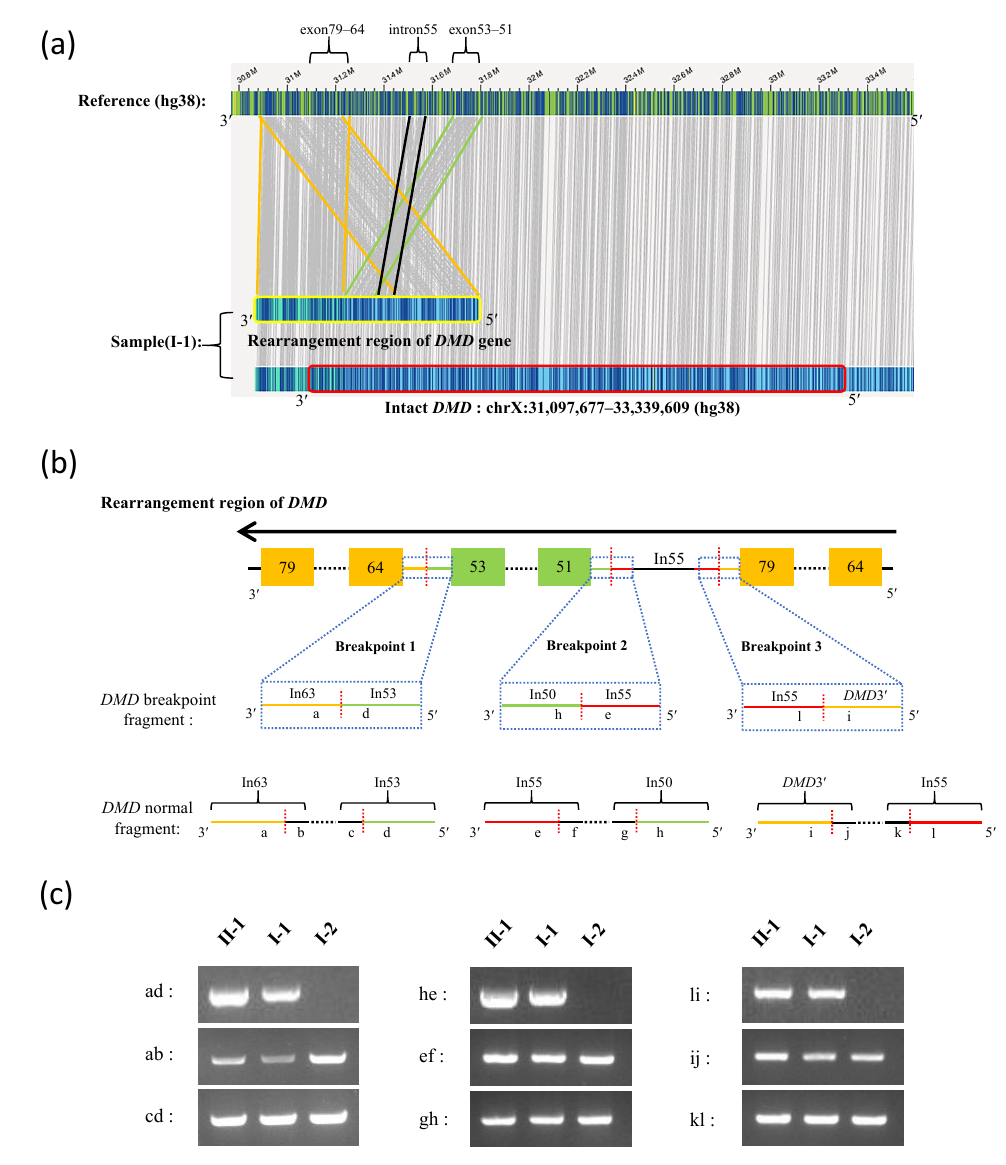
Figure 2. Long-read sequencing and breakpoint analysis of the DMD gene. ( a ) The DMD gene structure detected by Bionano SaphyrTM optical genome mapping. Compared with the human reference genome (hg38), the intact DMD gene is marked by a red border, and the rearrangement region of the DMD gene is marked by a yellow border. Gray vertical lines represent matching sequences between the sample DMD gene and the reference genome. The region between orange, black, and green lines represent DMD duplications in exons 79–64, intron 55, and exons 53–51, respectively. ( b ) The pattern of rearrangement in the DMD gene and the breakpoint structures. The orange- and green-filled boxes represent the exons. The black horizontal line represents introns. The black horizontal dashed line represents contiguous exons and introns of the DMD gene. The red vertical dashed line represents the breakpoint site. The blue dashed frame represents the magnified breakpoint structure, and “in” represents intron. ( c ) PCR verification of the breakpoint junction sequence and normal sequence of the DMD gene using gDNA from the proband (II-1) and her parents (I-1 and I-2): “ab” and “cd”, “ef” and “gh”, and “ij” and “kl” represent flanking sequence of the DMD gene breakpoint 1, 2, and 3, respectively; “ad”, “he”, and “li” represent DMD junction sequences of breakpoint 1, 2, and 3,